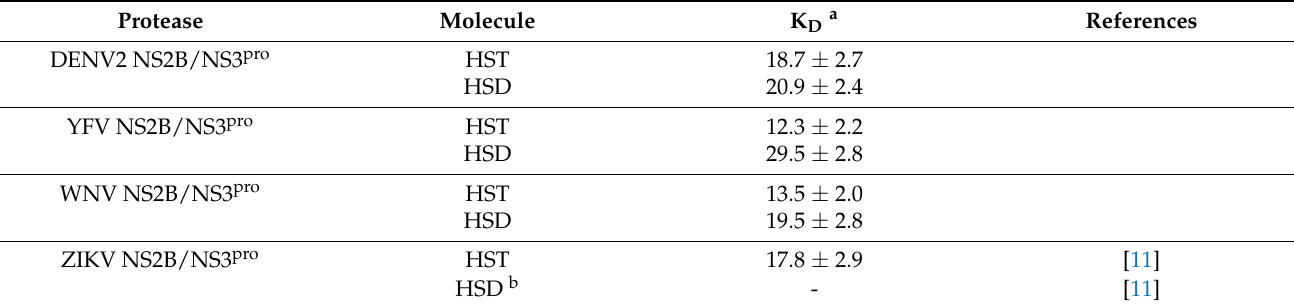
Table 2. K D values of HST and HSD with DENV2, YFV, WNV, and ZIKV NS2B/NS3 pro , as determined by TFS. Protease Molecule K D